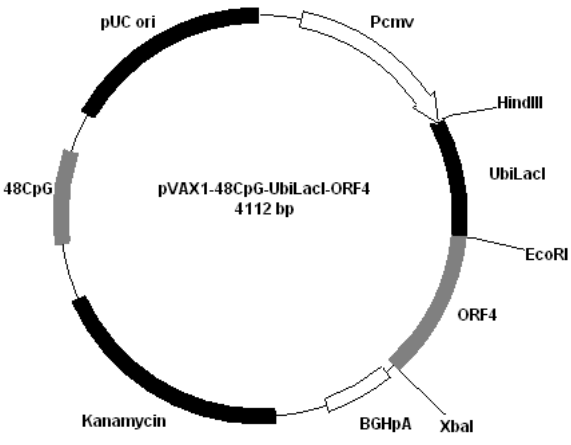
Figure 4. Plasmid pVAX1-48CpG-UbilacI-ORF4.